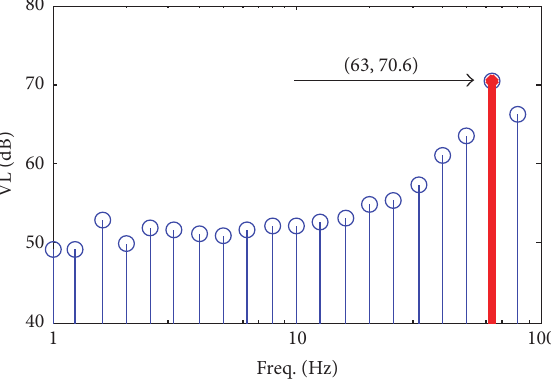
Figure 6: Frequency-weighted vibration levels on 1/3 octave band at measurement point